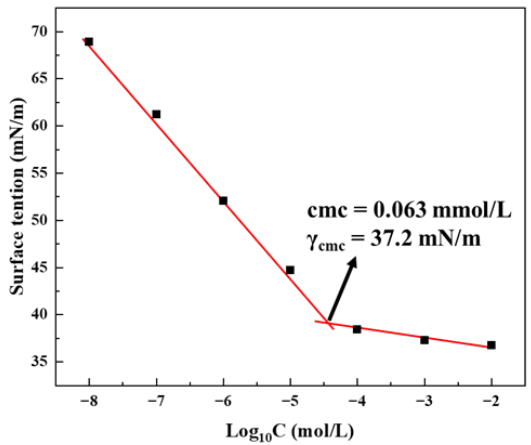
Figure 5. Surface tension plot for GOHAC.